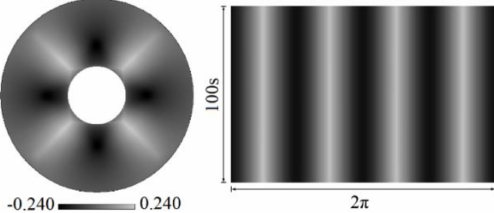
Figure 5. Concentration oscillations ( left ) and spatial-temporal diagram (STD) R = 0.65 ( right ) when Re T = 3943 without rotation.